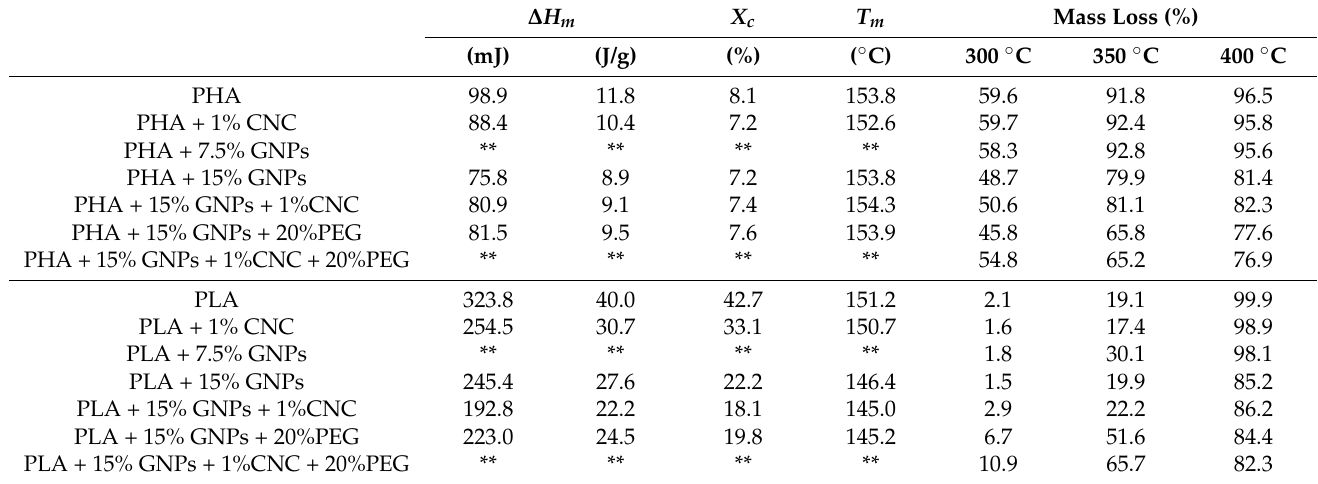
PHA + 7.5% GNPs Table 2. Summary of results obtained by physical characterization of PHA and PLA composites with different additions (GNPs, CNC and PEG).